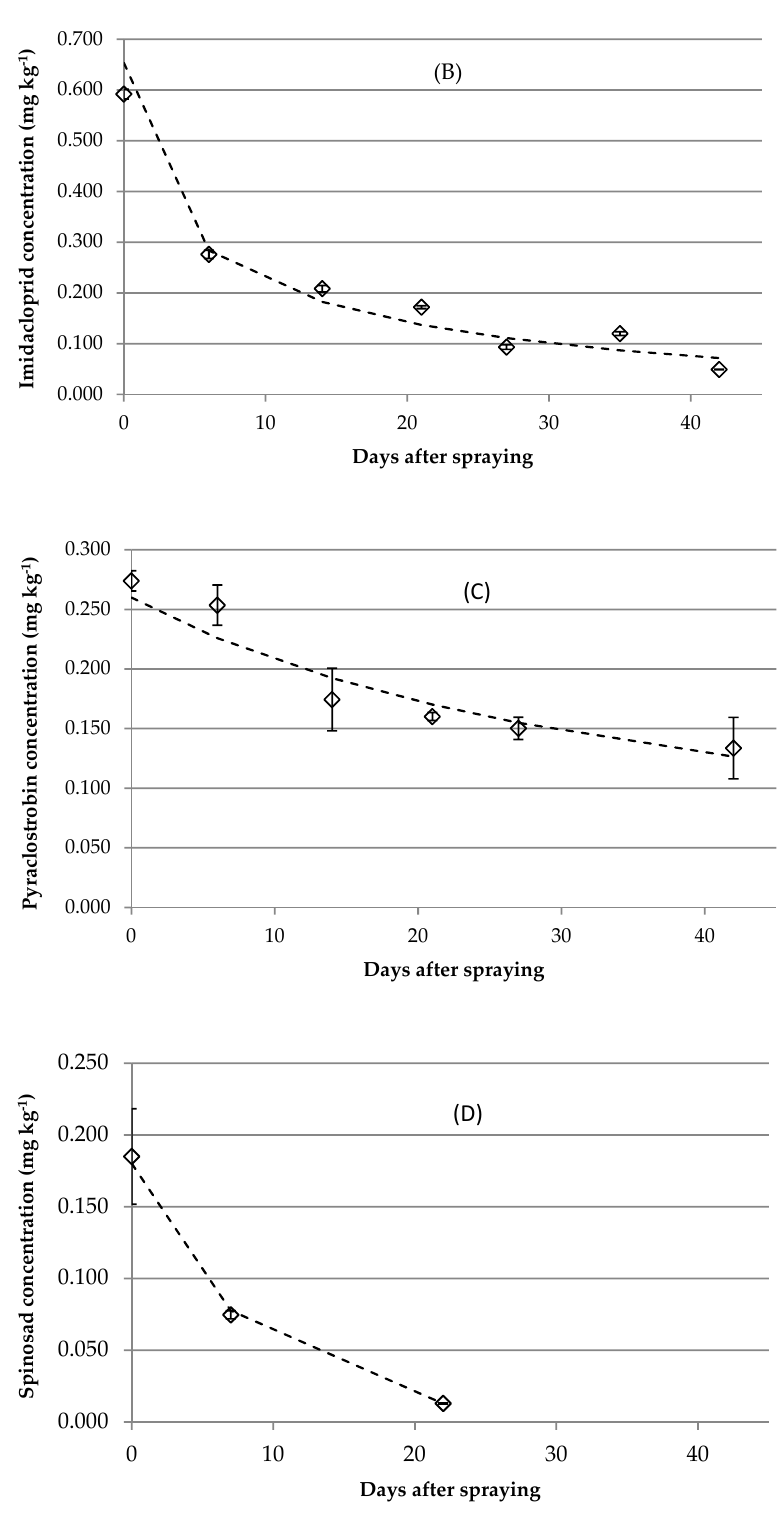
Figure 3. Dissipation curves for difenoconazole ( A ); imidacloprid ( B ); pyraclostrobin ( C ) and spinosad ( D ) in Clementine mandarin in the days after spraying. - ♦ - Indicates experimental data. — Indicates the back-transformed dissipation curve (the best-fitted mathematical model: 1st-order equation for ( A , D ) Root factor (RF) 1st-order equation for ( B ) and 2nd-order for ( C